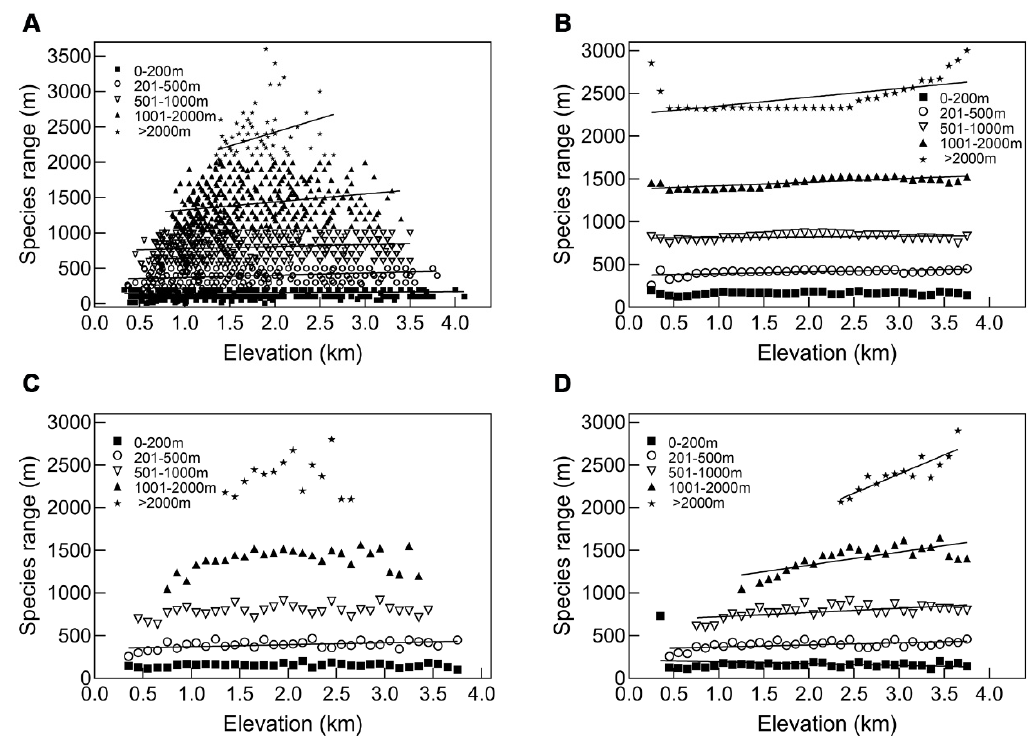
Figure 7. The altitudinal patterns of species range after grouping in cross-species method ( A ), Stevens method ( B ), Rohde’s midpoint method ( C ), and Pagel’s method ( D ).